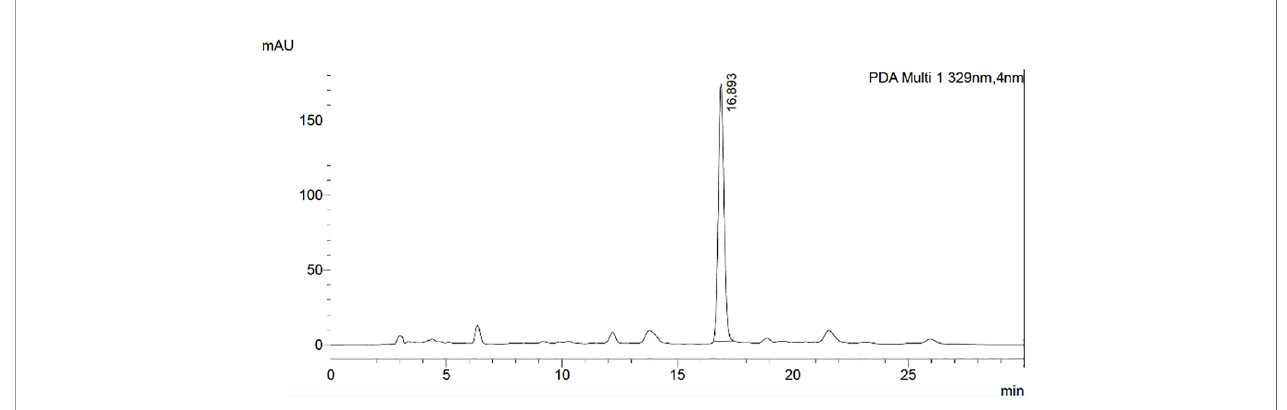
FIGURE 1 | HPLC Chromatogram of the crude ethanolic extract of Leptohyptis macrostachys . Chromatographic conditions: Kromasil ® 100-C-18 column (250 × 4.6 mm - 5 m m), methanol/water as mobile phase with fl ow rate of 1 ml/min.